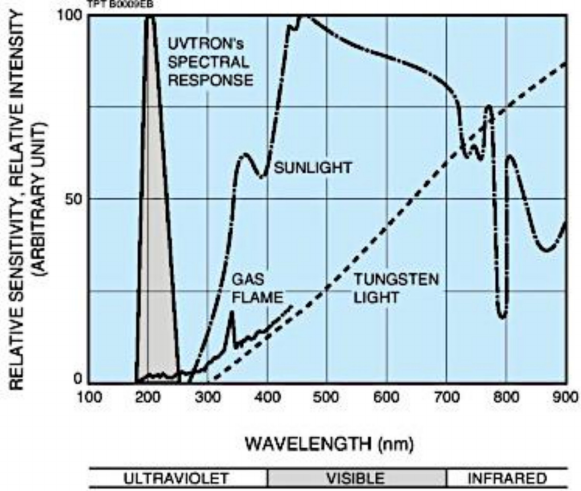
Figure 2. Response range of the UV sensor [14].